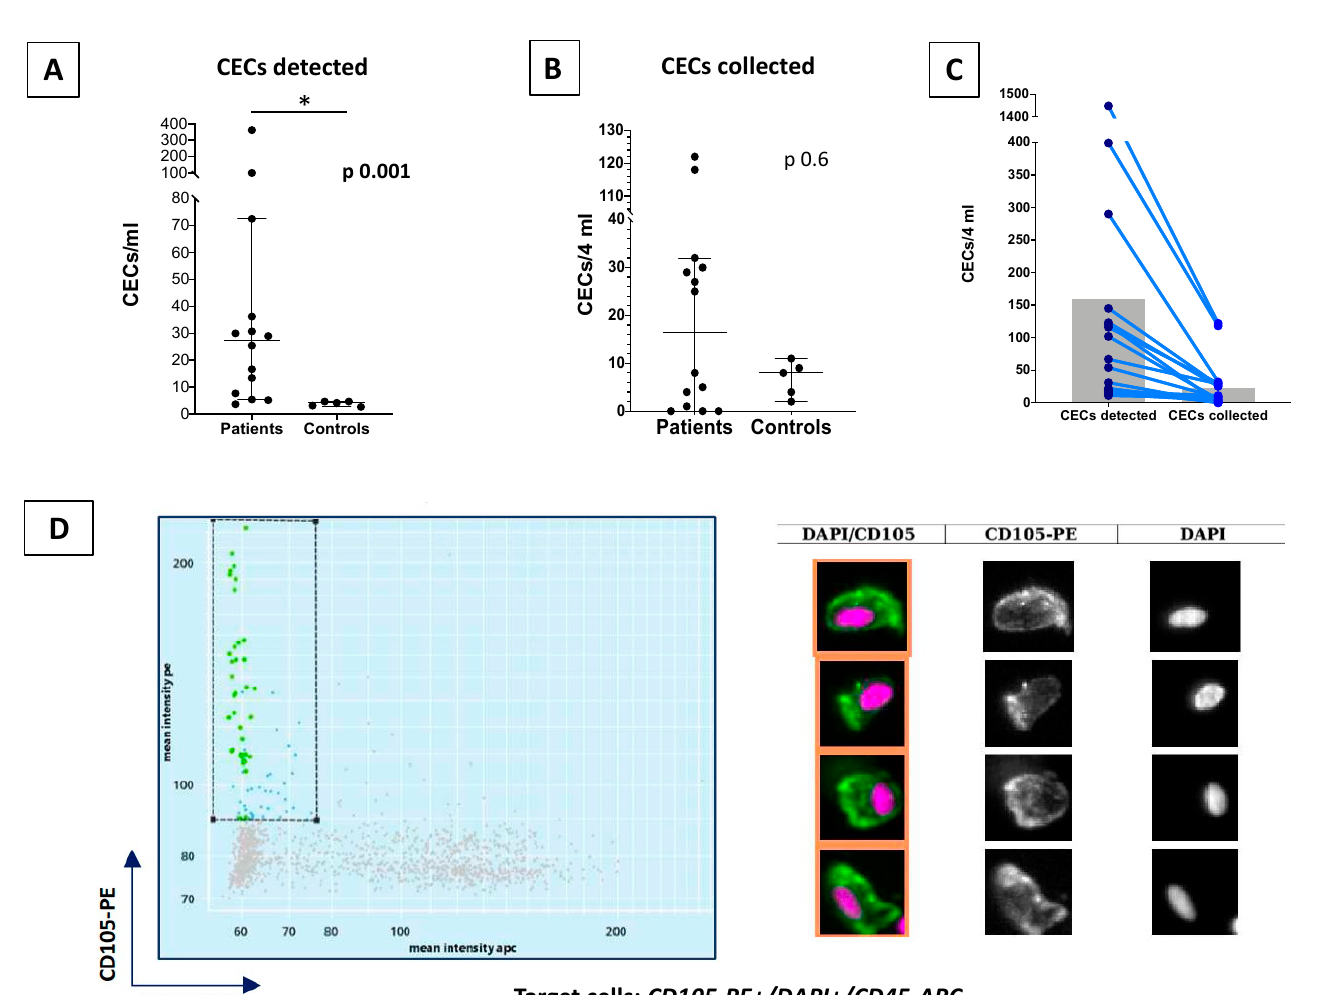
Figure 2. CellSearch detection of CECs and DEPArray imaging. ( A ) The CECs detected per mL in PMF patients and healthy controls. PMF patients presented a significative higher level of CECs ( p = 0.001). ( B ) The CECs collected per mL in PMF patients and healthy controls. ( C ) The CECs quantitative difference comparing the CECs detection and collected levels. ( D ) DEPArray imagines comparision. On the left, the DEPArray scatter plot, which is based on mean fluorescence intensity and with the gate for CD105-PE positive (Y axis) and CD45-APC negative (X axis) cells. On the right, the original Cell Search images. In the first column the cells selected as CECs, which presented in purple the nuclear stain DAPI, while in green the CD105 staining. In the second column the selection of CD105-PE staining, while the third shown the DAPI staining. CECs were defined as CD105PE+/DAPI+/CD45APC-. The CECs median comparison was made using the Mann-Whitney test. * p < 0.05.